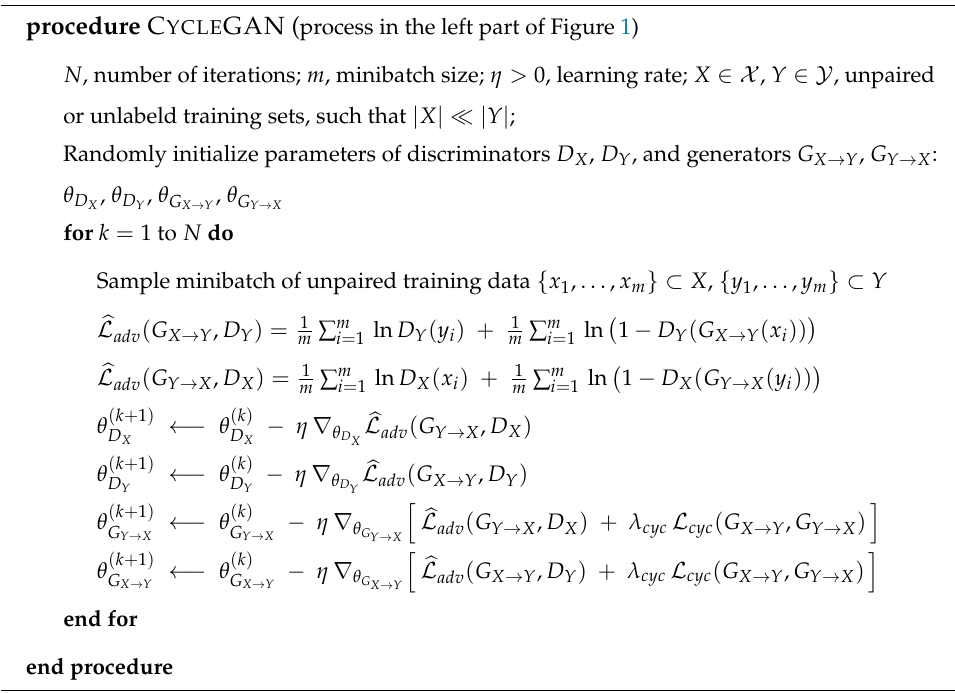
Algorithm 1 CycleGAN training